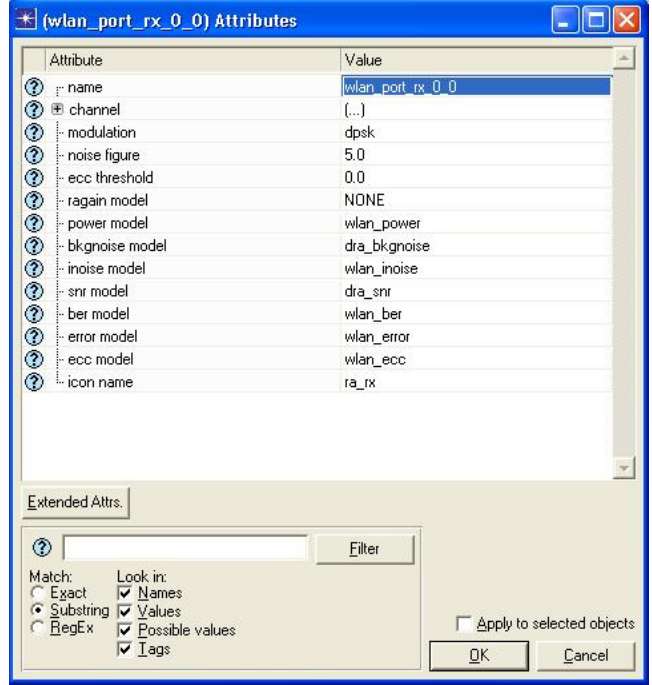
Figure 4. Noisy Channel Configuration in Riverbed Modeler Simulator.